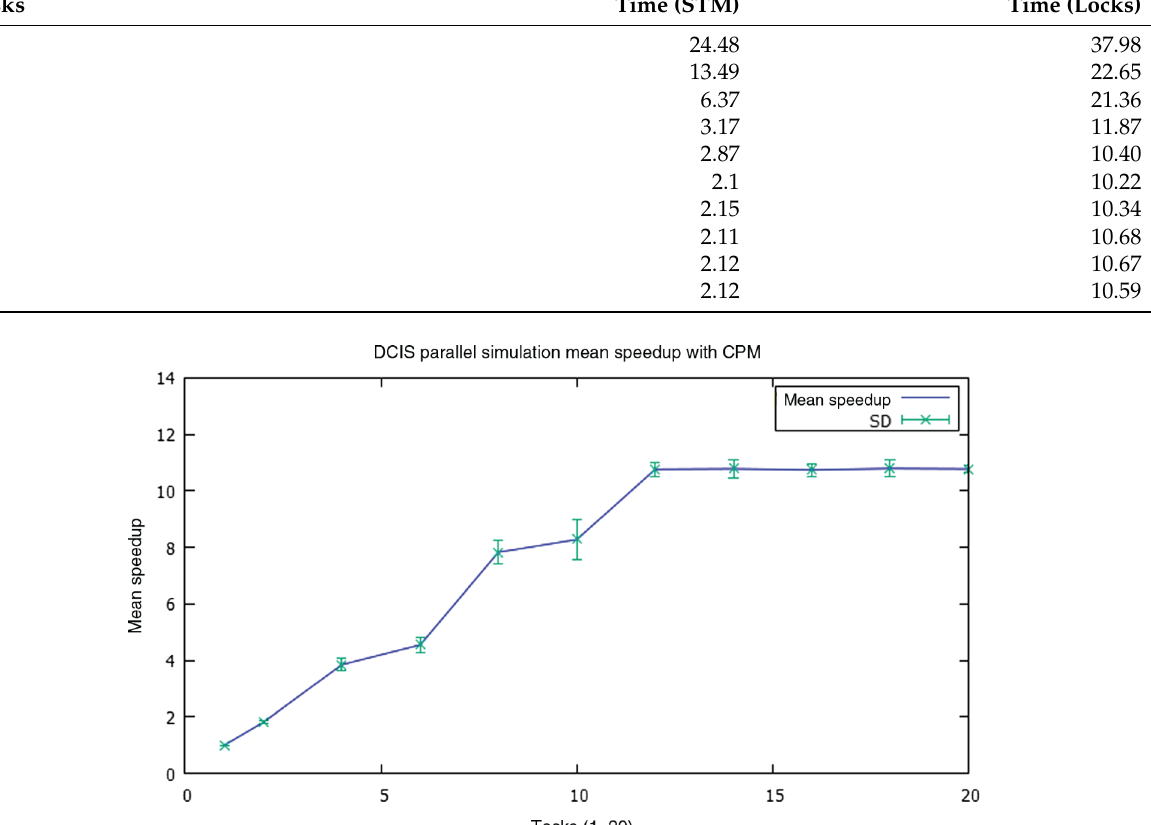
Table 2: STM vs. locks comparison (in seconds). Tasks